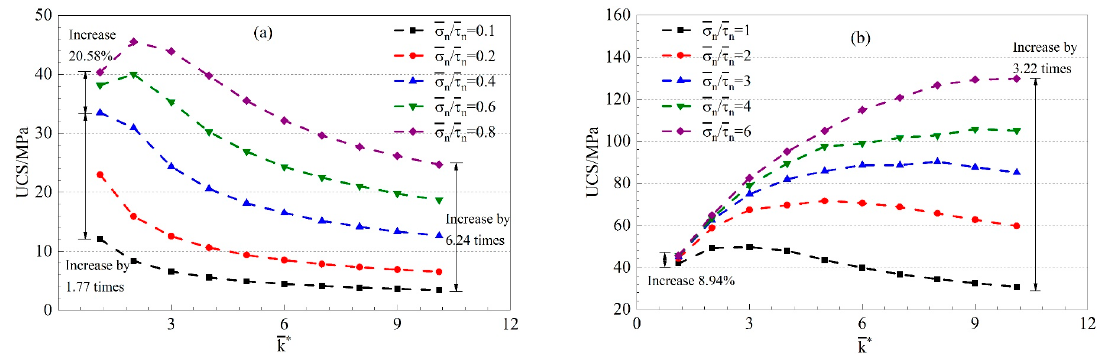
Figure 2. Relationships between bond normal-to-shear stress ratio ( σ n / τ n ) and bond normal-to-shear ∗ sti ff ness ratio ( k ) versus uniaxial compressive strength (UCS). ( a ) σ n / τ n < 1, ( b ) σ n / τ n >